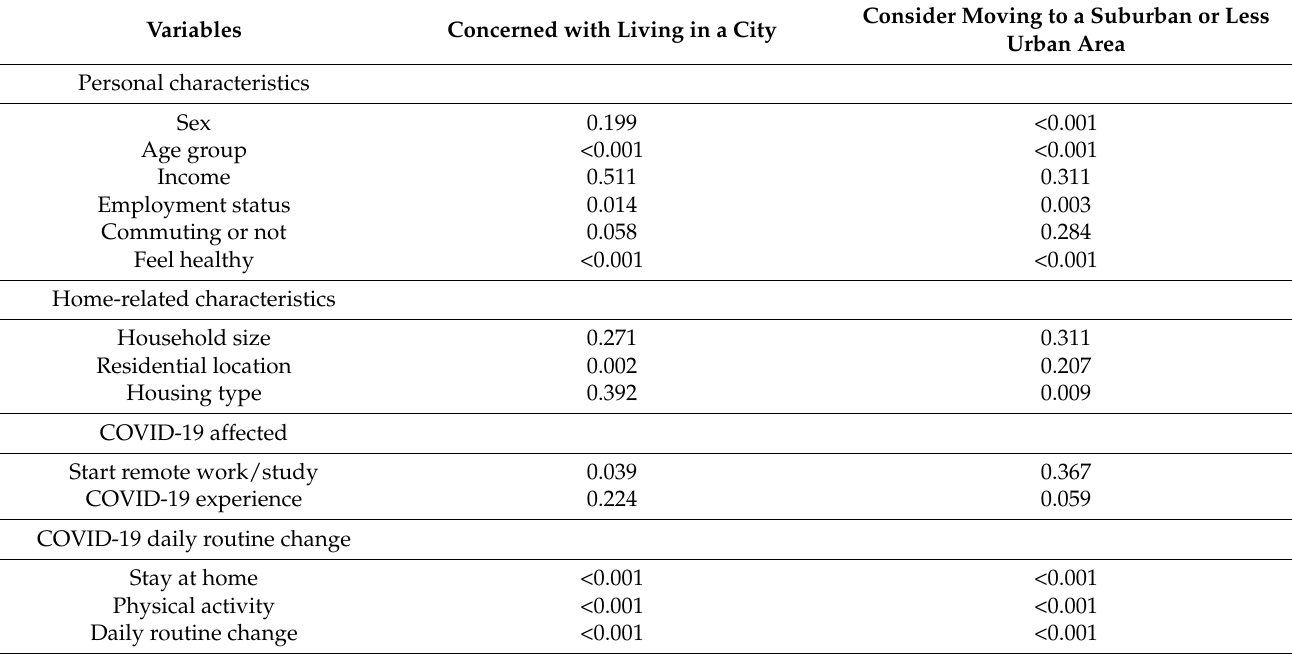
Table 4. Chi-square test p -values, indicating independencies between variables.